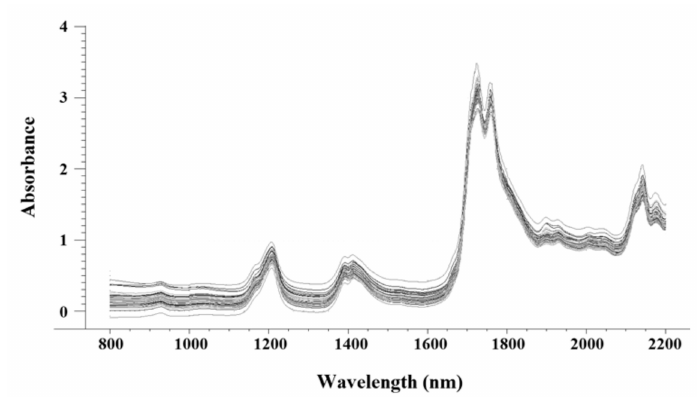
Figure 1. Near-infrared spectra of the waste cooking oils (WCO) used in this research.